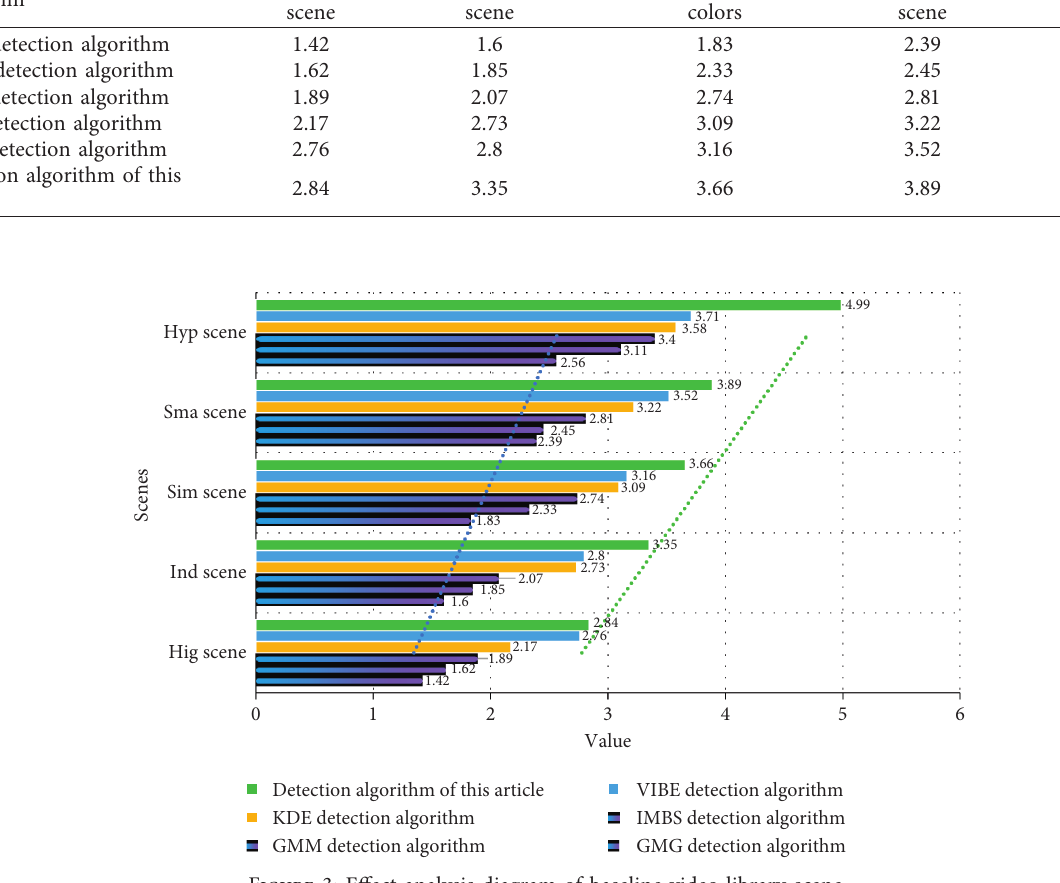
Figure 3: Effect analysis diagram of baseline video library scene. Table 3: Effect analysis data of dynamic background video library